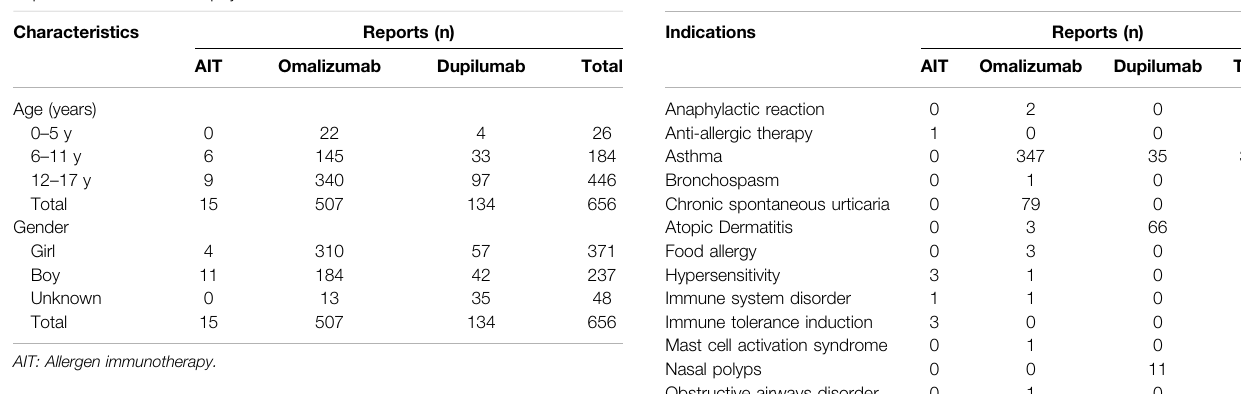
( Table 6 ). Death rate of AIT was the lowest (0), while death rate of dupilumab was the highest (4.76%). However, no differences were